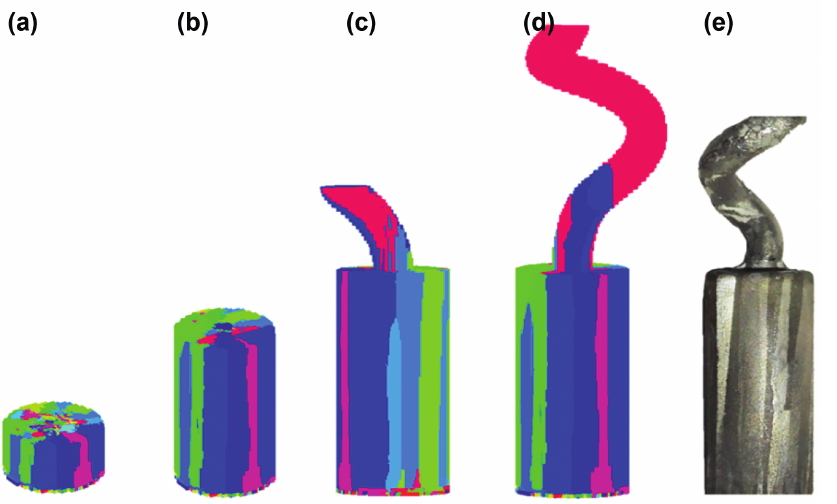
Figure 7: Simulation and experimental results of the grain structure for the LMC process: (a) t = 90 s; (b) t = 120 s; (c) t = 150; (d) t = 180 s; and (e) experimental